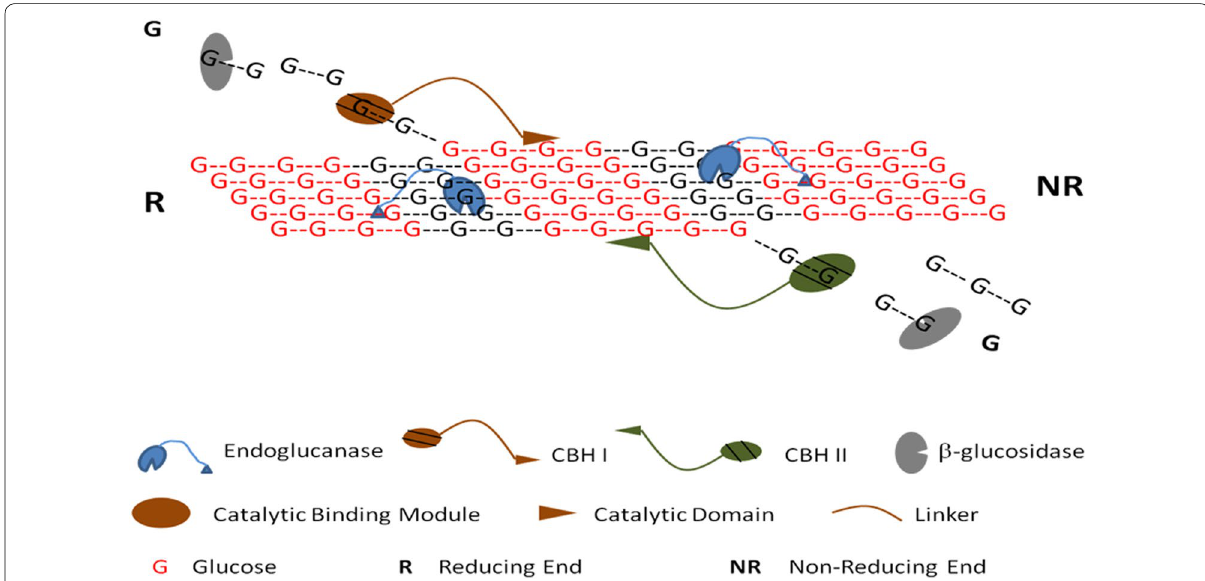
Fig. 1 Hydrolysis of cellulose by action of various cellulase enzymes. Red color represents crystalline region and black color are in amorphous region (Adapted from Kumar and Murthy